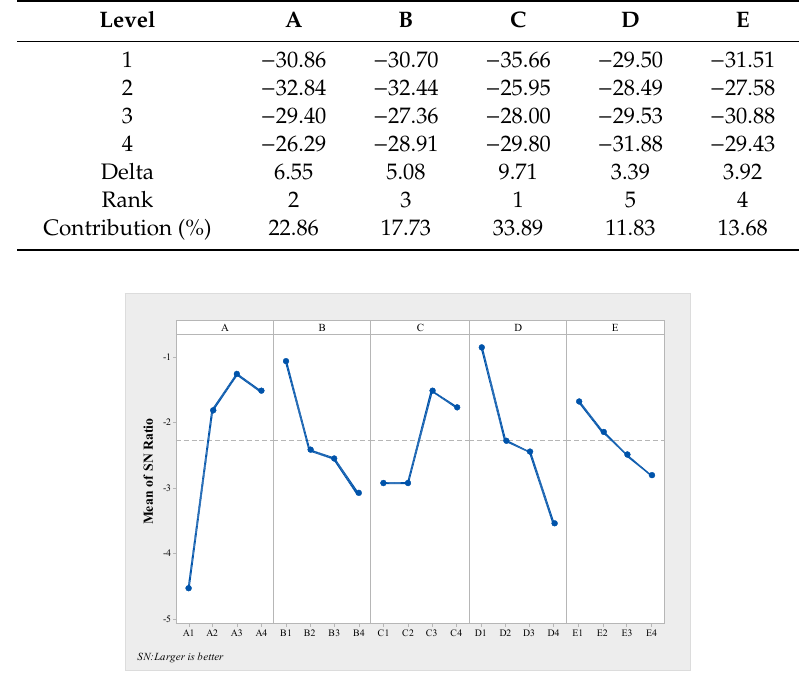
Table 6. Factorial e ff ect of Fr .